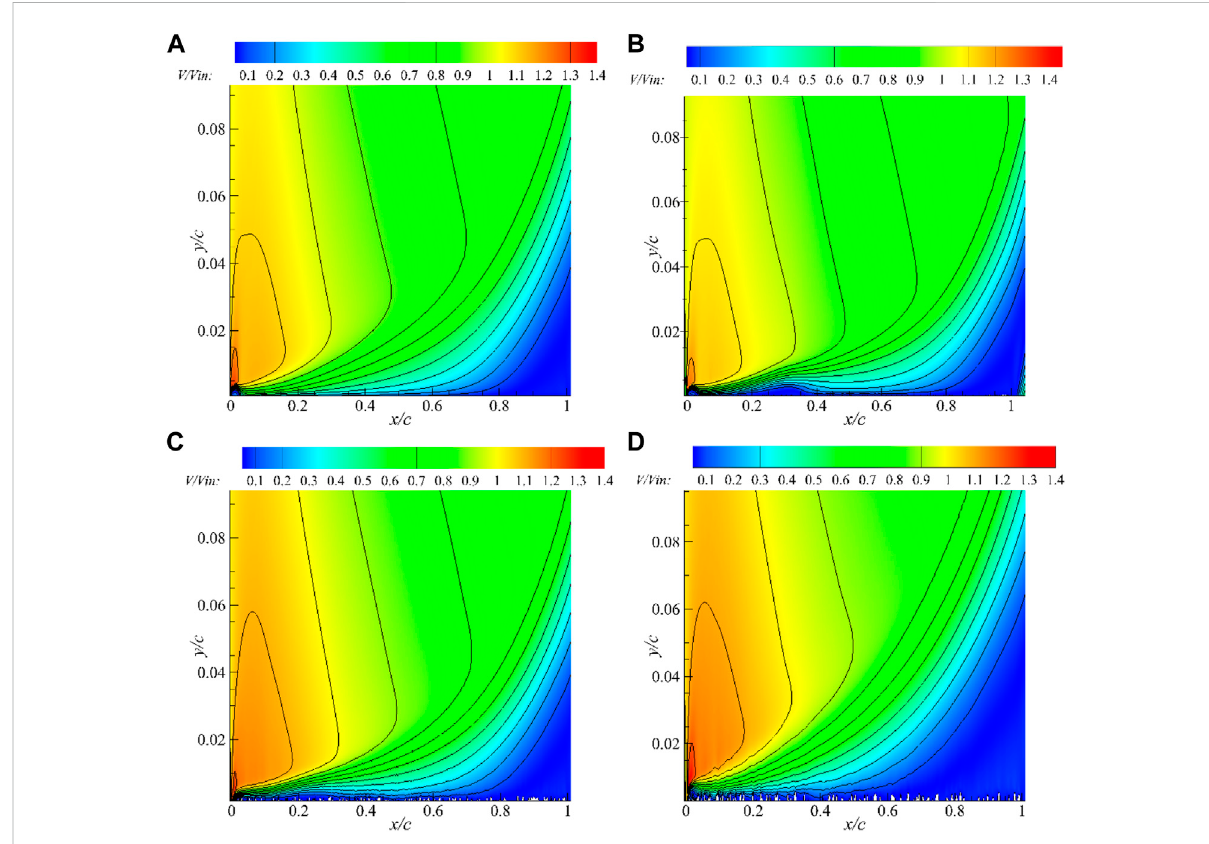
FIGURE 9 V/V in in the cascade passage. “ V ” is the velocity and “ Vin ” represents the velocity of the inlet boundary.